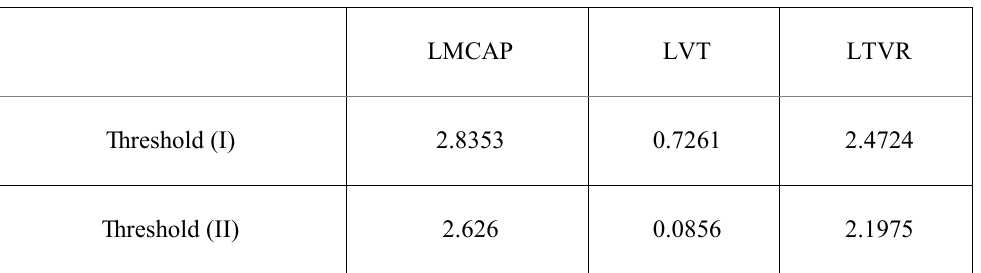
Table 11. threshold estimates for stock market